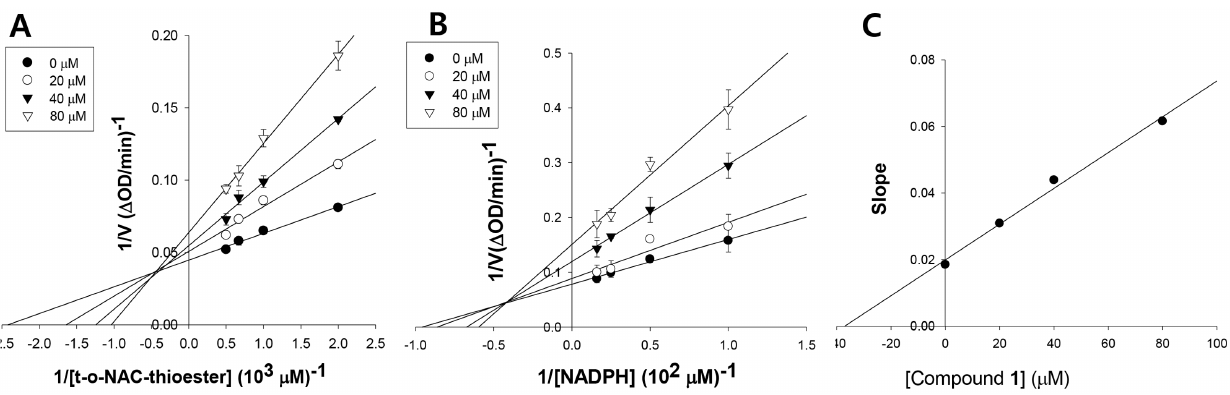
Figure 2. The mechanism of inhibition of Staphylococcusaureus FabI by meleagrin respective to t-o-NAC thioester (A) and NADPH (B), and